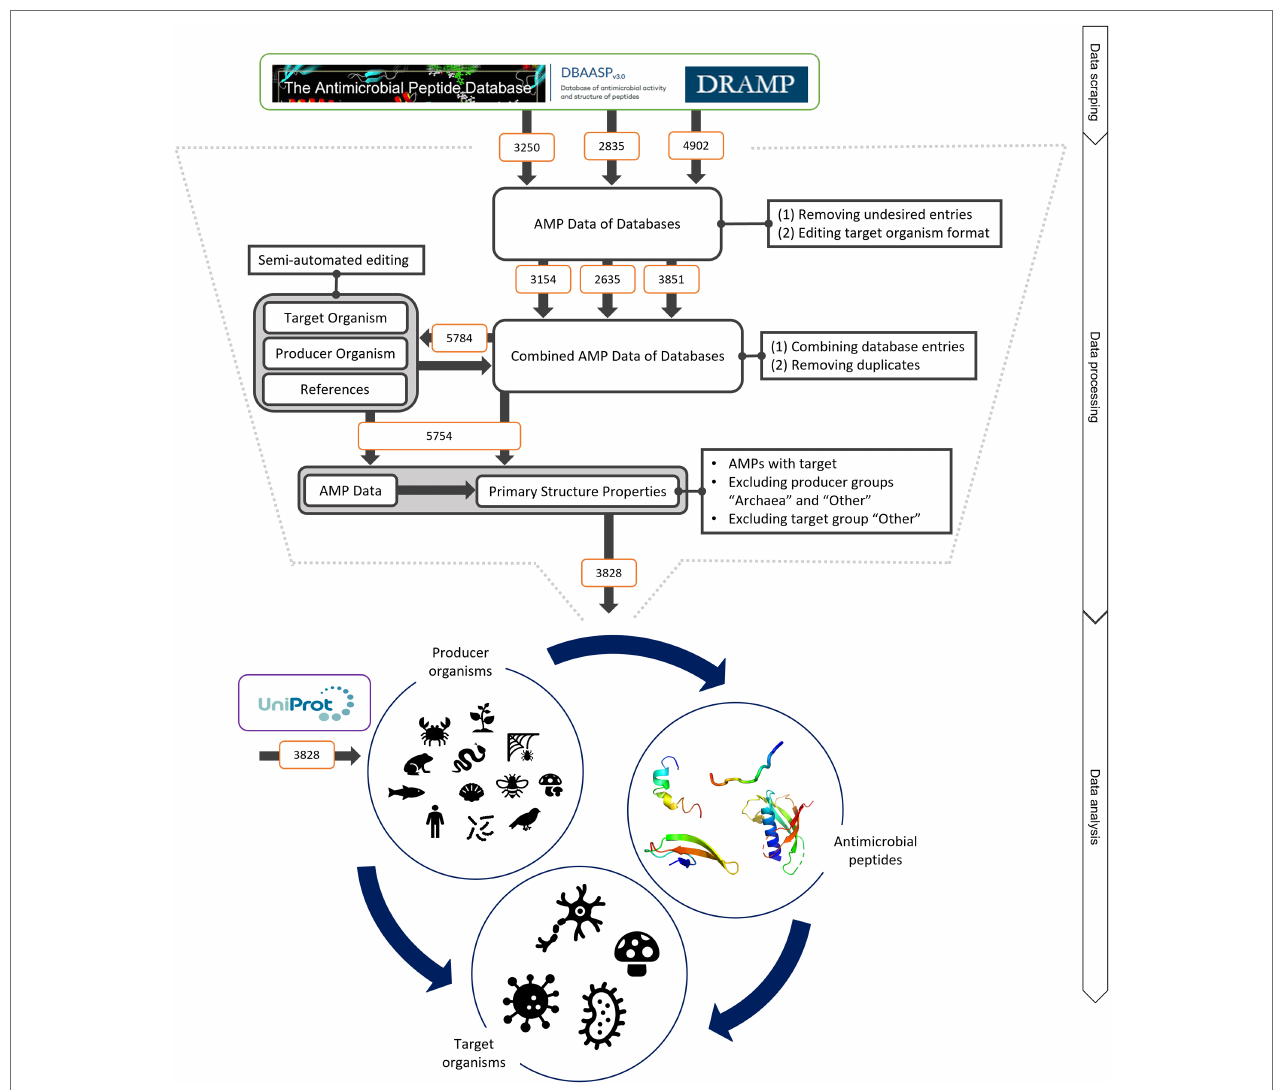
FIGURE 1 | Schematic of data mining, processing and analysis process. Data were retrieved from the three databases APD, DRAMP and DBASSP and subsequently filtered after predefined criteria (no double sequences, only peer-reviewed entries, no synthetic peptides, etc.). This semi-automated editing of the entries improved the data for automated processing. The producer organism group ‘Archaea’ and ‘Other’ as well as the target organism group ‘Other’ were excluded since the number of peptides was not statistically evaluable. This led to total of 3,828 peptides to be analysed. The same amount was retrieved from UniProt to compare the AMP structural features to randomly selected peptides. The peptides were examined regarding (i) the relationship of the producing organism group and the AMP structure, (ii) the dependence of the investigated target organism and the AMP producing group and (iii) the influence of the AMP structure on the target organism. For further details, see